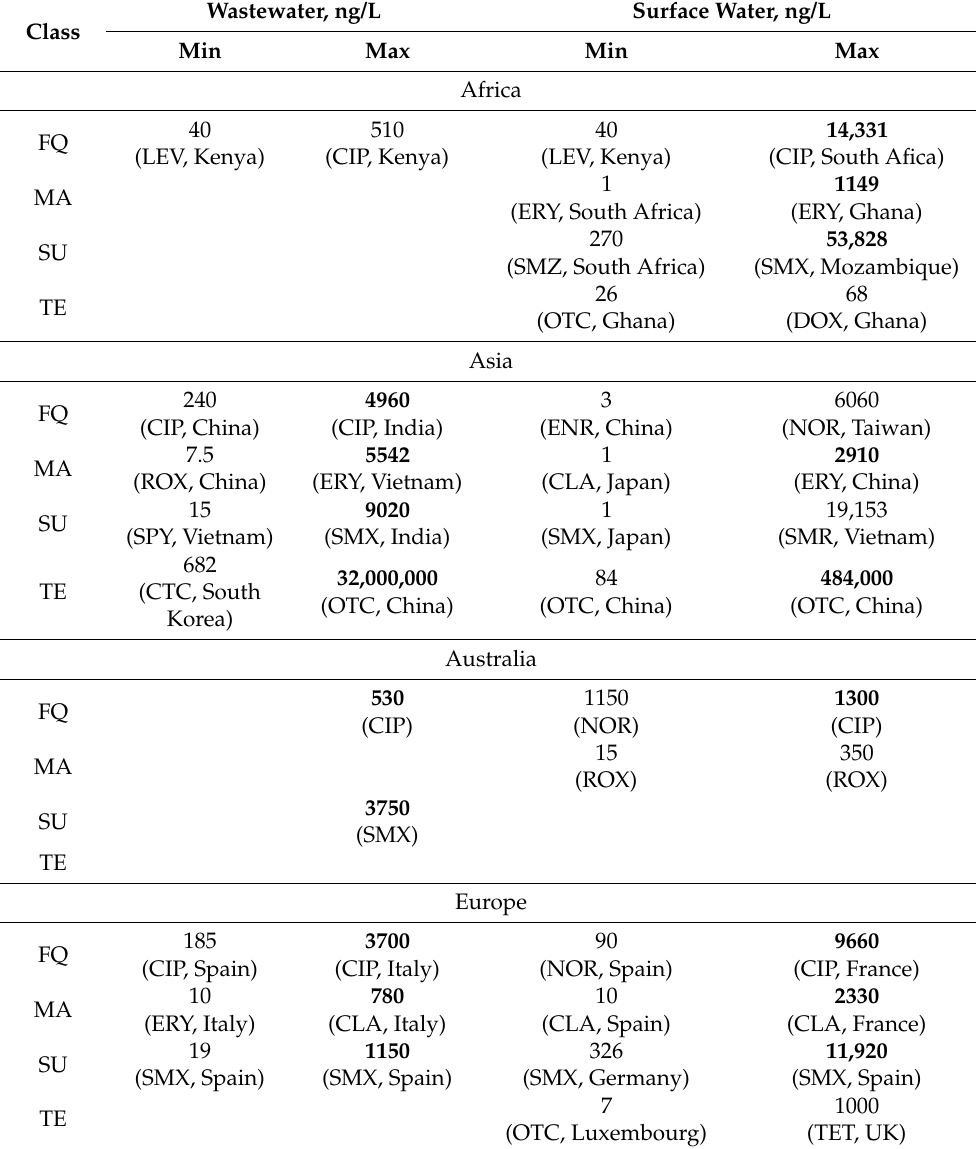
Table 1. Reported concentration range for antibiotics of different classes in wastewaters (adapted from refs. [4,6]) and surface waters (adapted from ref. [66]). Values that exceed the predicted no-effect concentrations (PNEC) are shown in bold (PNEC values are based on eco-toxicology data generated by the member companies of Antimicrobial Resistance Industry Alliance and relevant peer-reviewed literature